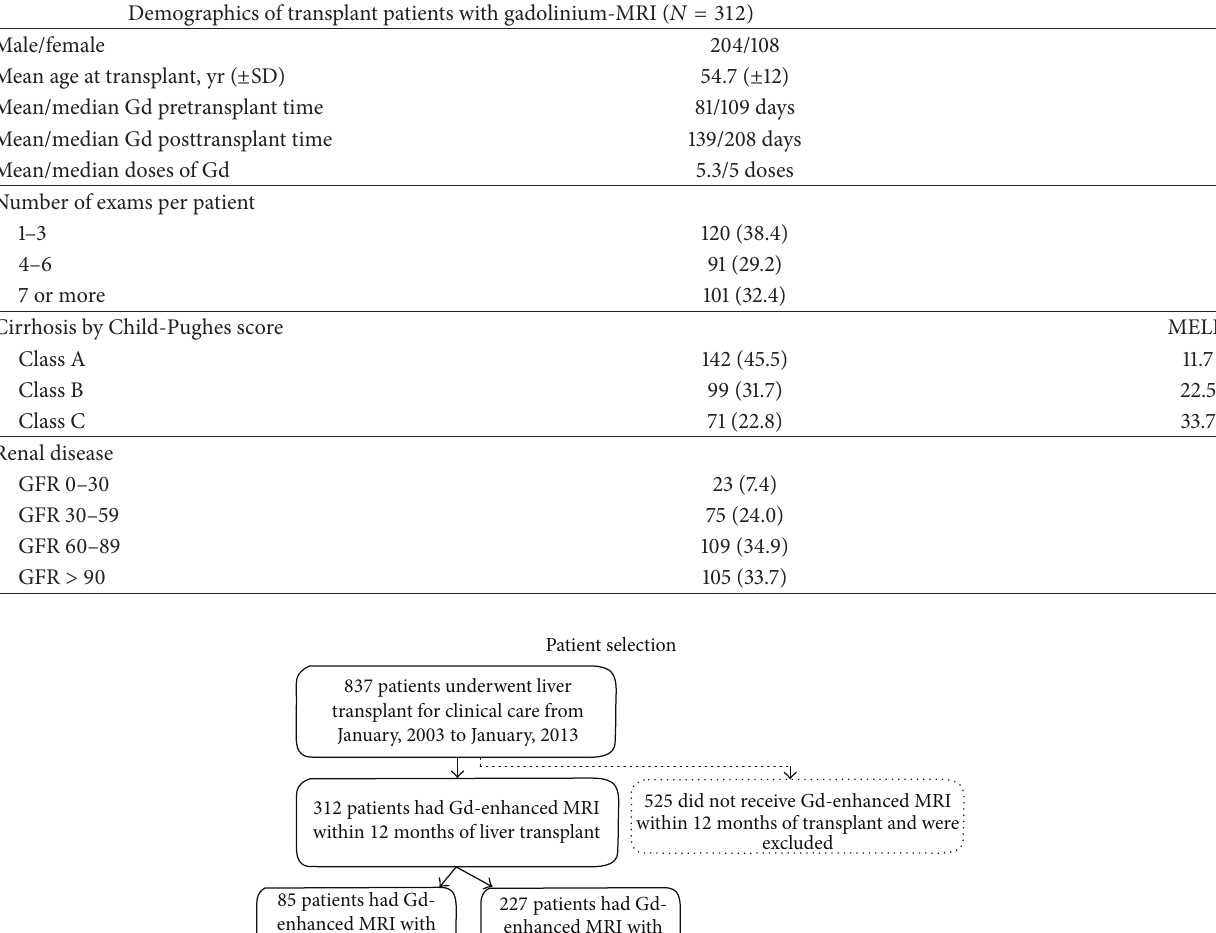
Table 1: Demographics of patients who had undergone liver transplantation with documented GD exposure. Numbers in parenthesis represent percentages. MELD represents the Model for End Stage Liver disease score average. GFR units equal mL/min/1.73 m 2 .